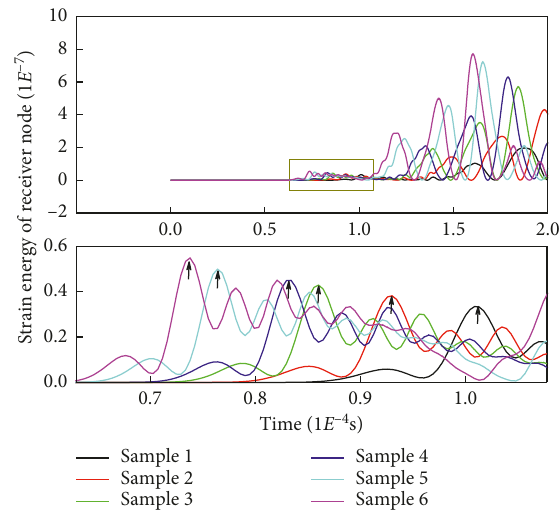
Figure 17: Strain energy of receiver